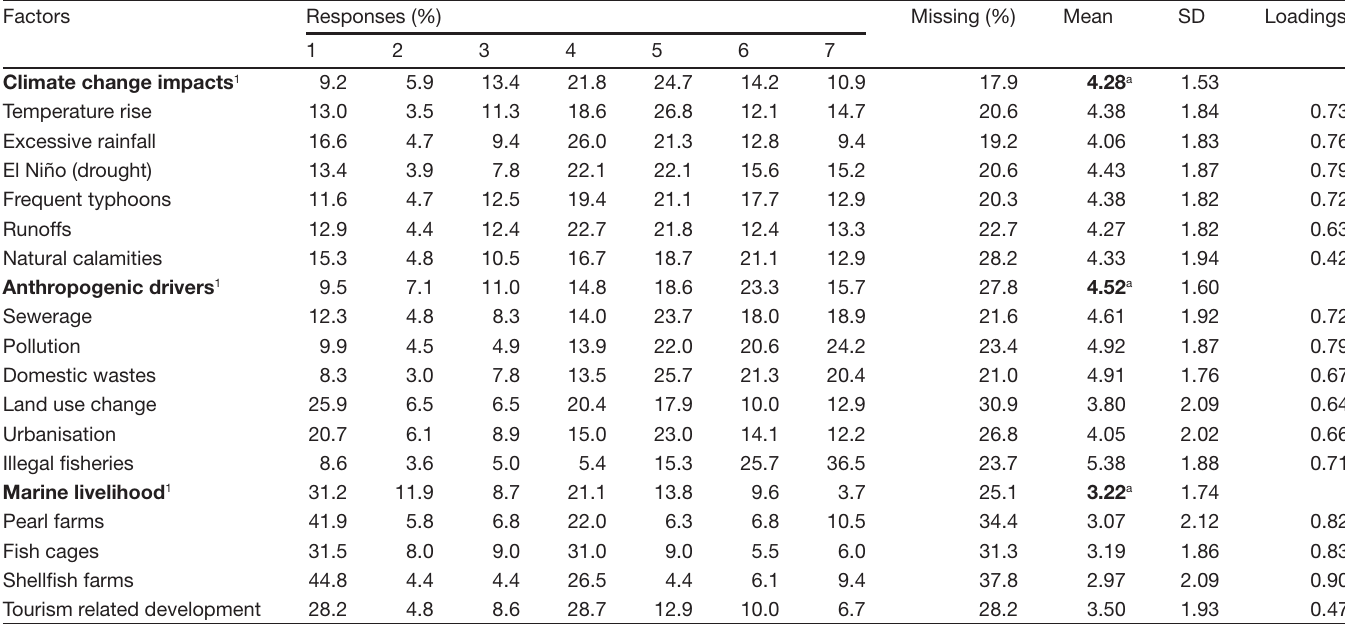
Table A2. Perceptions of factors affecting the coral reefs and seagrass beds. The response options provided to the respondents was a bipolar rating scale: 1 = fully disagree to 7 = fully agree. n = 291 Factors